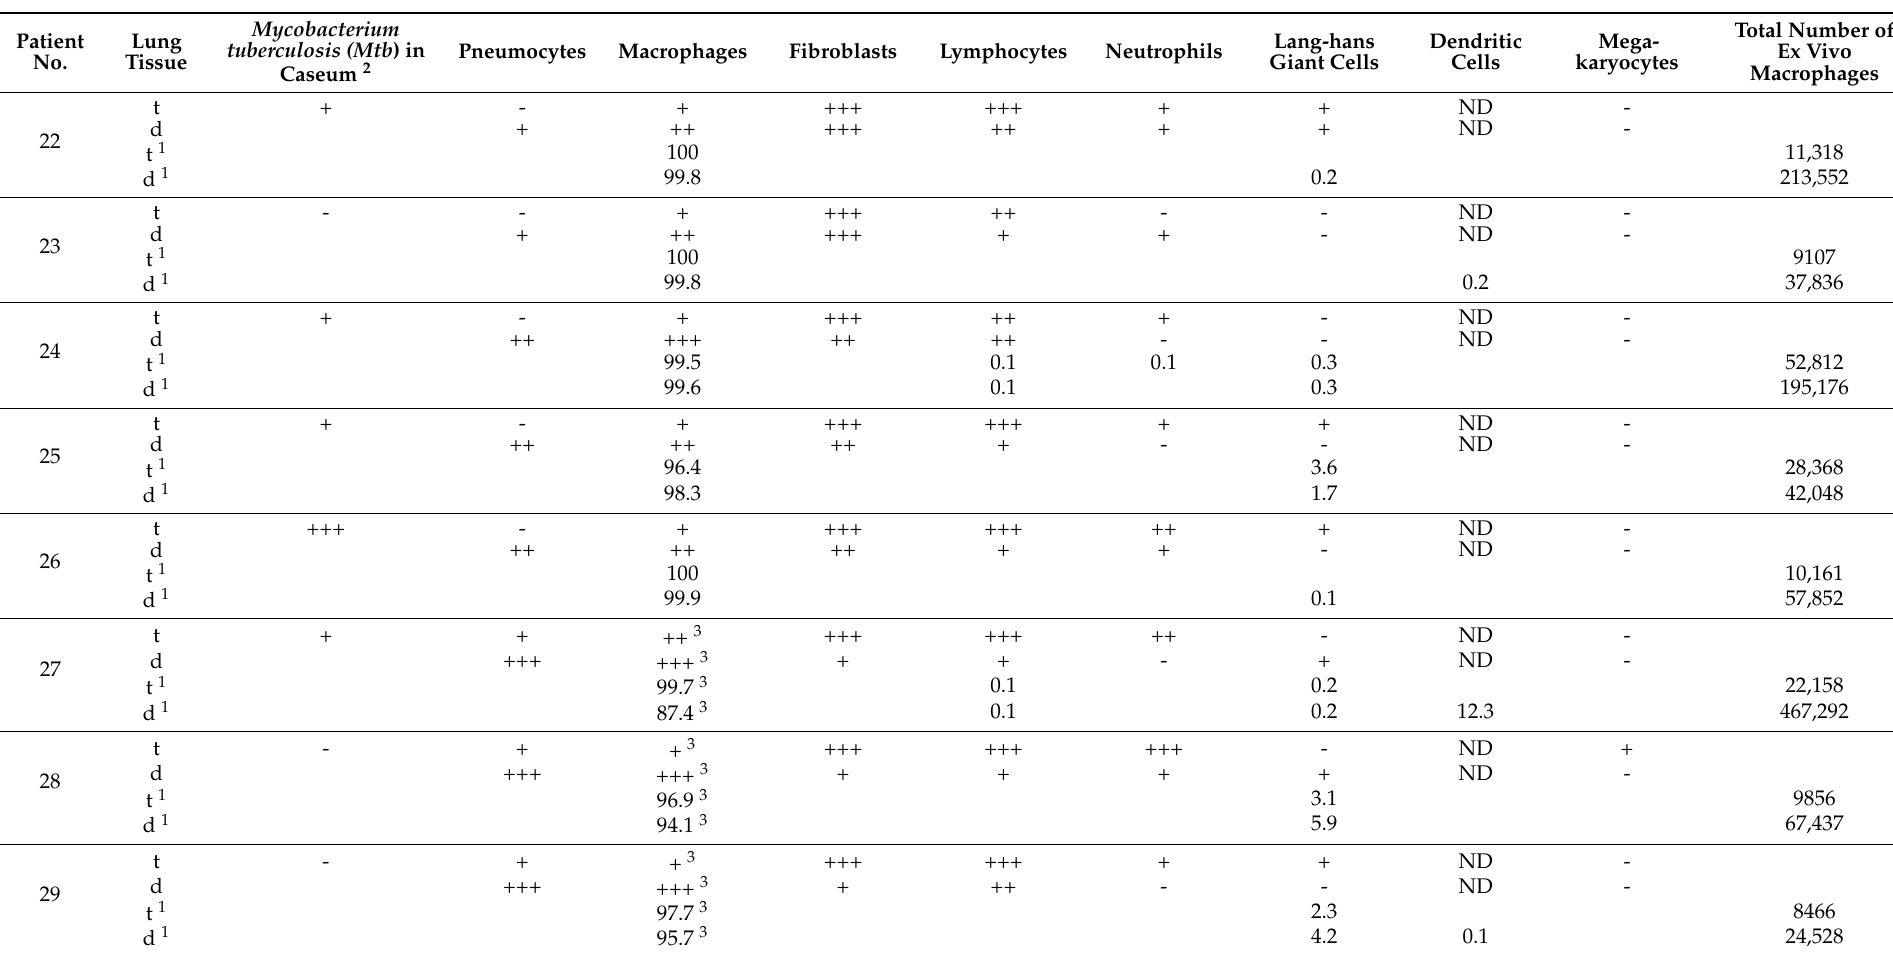
Table 1. Cells on histological sections and in ex vivo cell cultures ( 1 ) obtained from the tuberculoma walls (t) and the lung tissues distant from tuberculomas (d) for the same TB patients. Patient